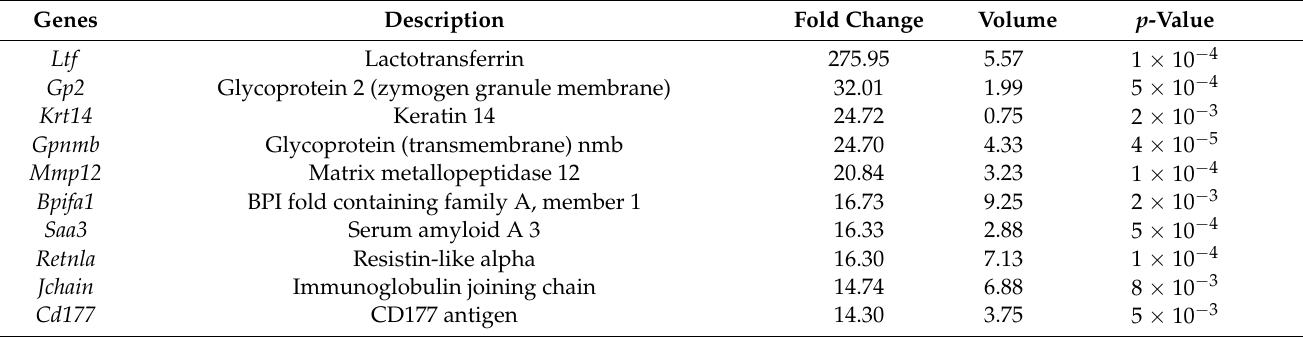
Table 2. Top 10 genes significantly upregulated by PHMG-P